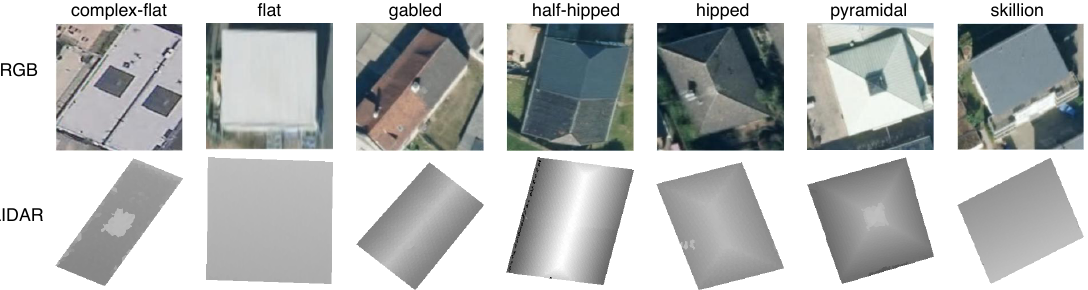
Figure 8. RGB and LiDAR example images of roof